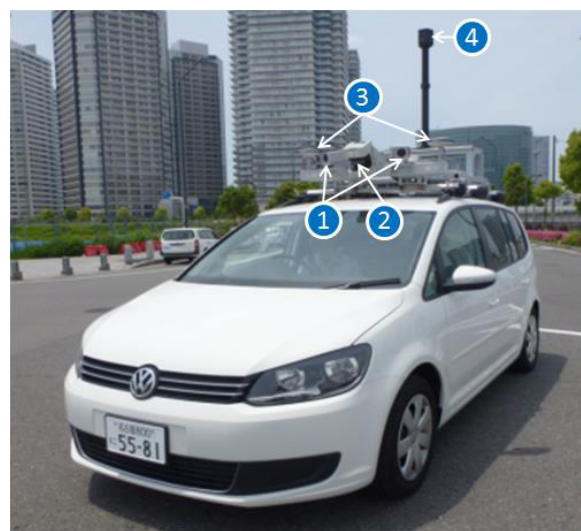
Figure 3. Overview of Mitsubishi MMS-X 220: ① frame video cameras; ② laser scanners; ③ GPS antennas; ④ Ladybug3 panorama camera.